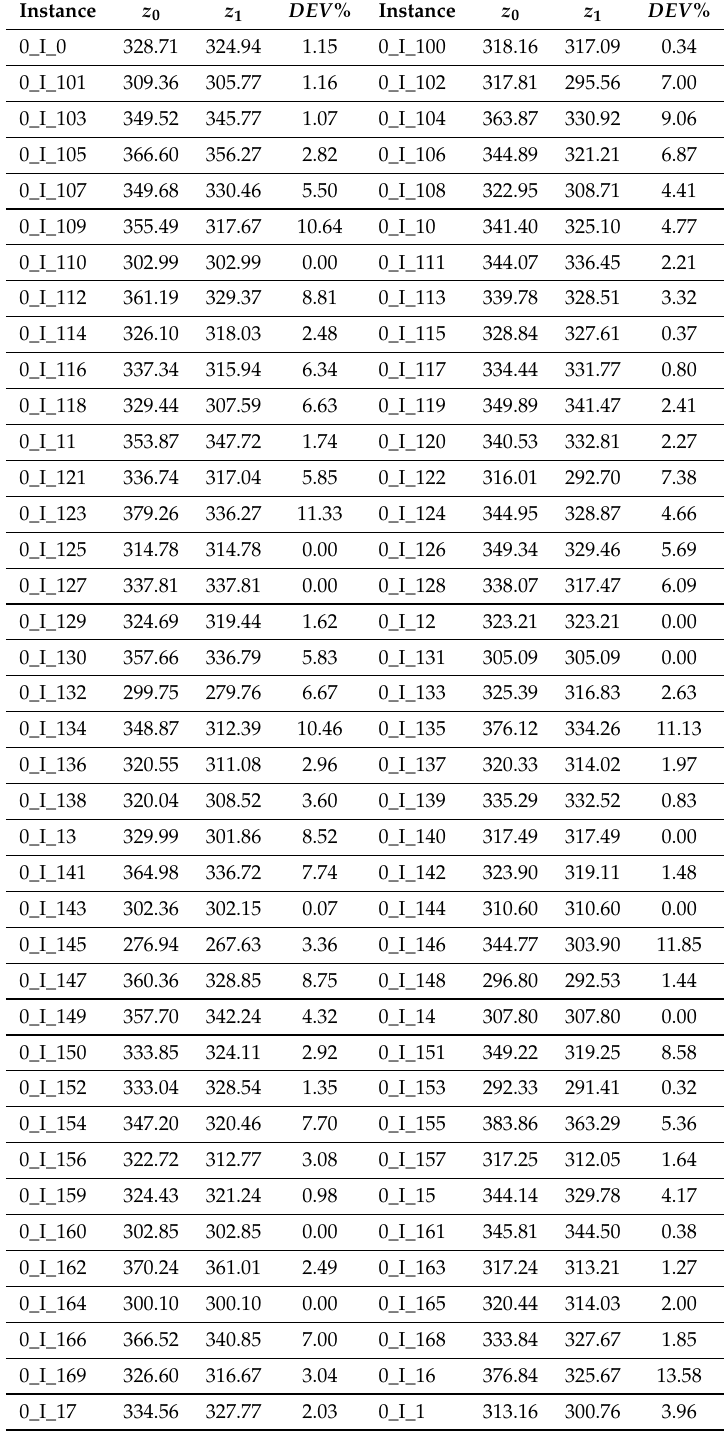
Table 6. Computational results for the Paris